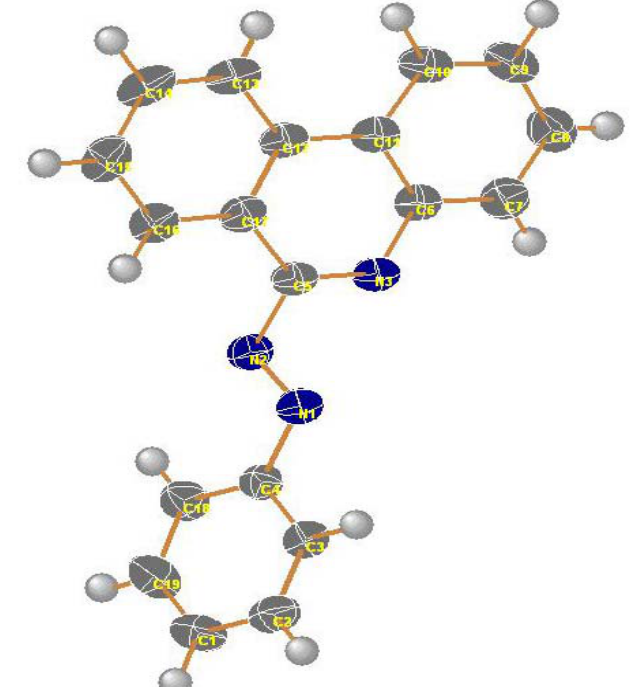
Figure 2. X-ray structure of compound 9a (thermal